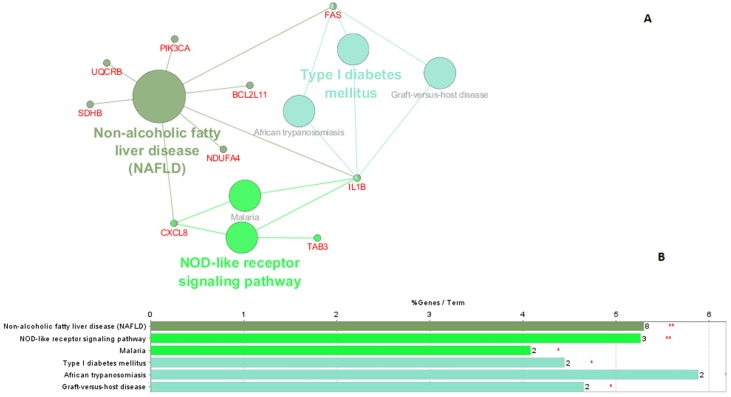
Functionally enriched KEGG pathways identified by ClueGO.(A) The size of the nodes reflects significance of the term. Network includes genes that are shared between different KEGG pathways (B) Chart represents significant KEGG pathways where bars show number of genes associated to each term. Level of significance for terms is marked using 1) **; if the term is over-significant (p-value<0.001), 2) *; if the terms is significant (0.001<p-value<0.05), and 2). (dot); 0.05<p-value<0.01).